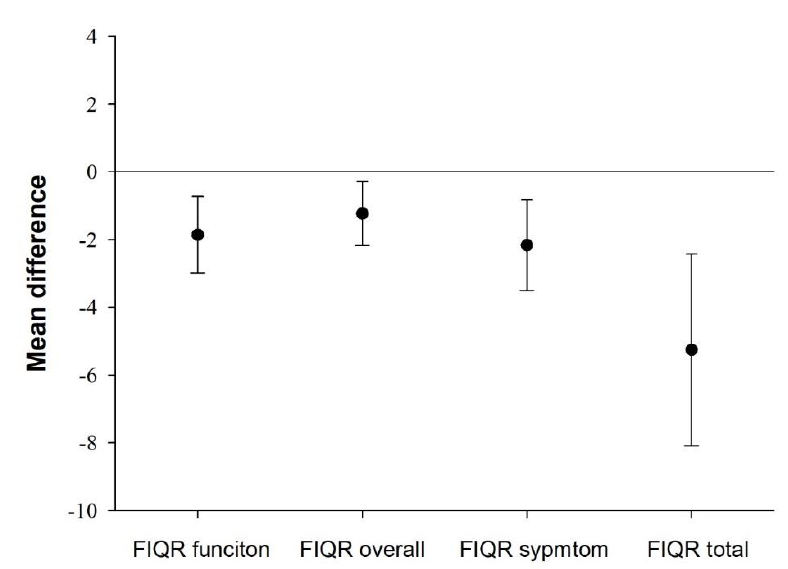
Figure 1. Mean differences with 95% confidence intervals in disease severity between participants not presenting ( n = 233) and those presenting sedentary bouts ≥ 60 min ( n = 218). All P ≤ 0.007. Analysis controlled for age, bouted moderate-to-vigorous physical activity, overall physical fitness and accelerometer wear time. FIQR, Revised Fibromyalgia Impact Questionnaire.